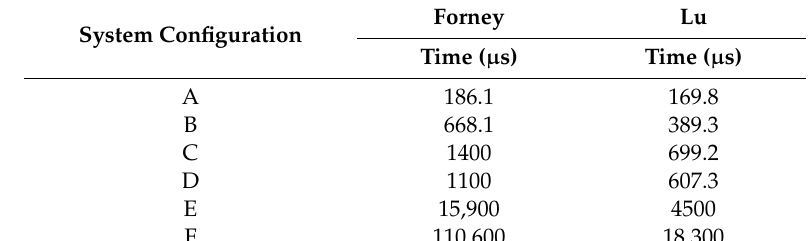
Figure 11. Graphical representation of the results of Table 4. ( a ) FPGA implementations resources’